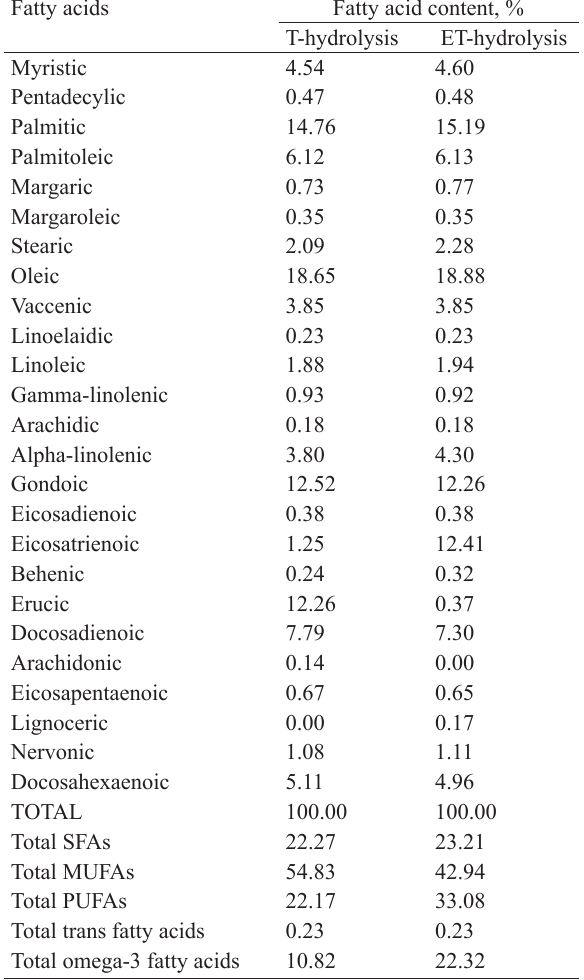
Table 7 Fatty acid composition of fat in sockeye heads after thermal- and enzymatic-thermal